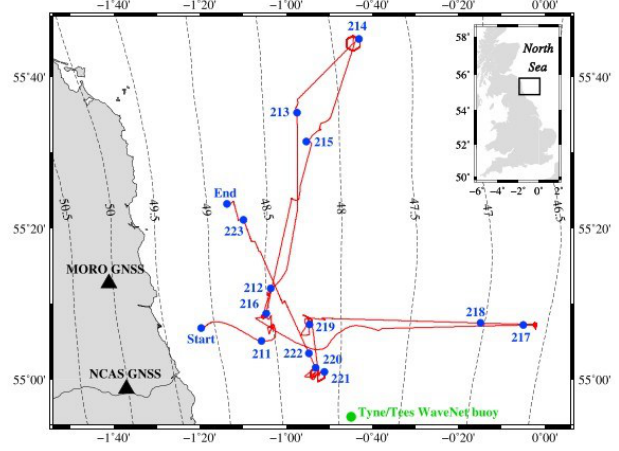
Figure 14. Wave glider’s track (red line). The dashed lines represent EGM2008 geoid height contours in meters [18]. Coasts 2022 , 2 , FOR PEER REVIEW